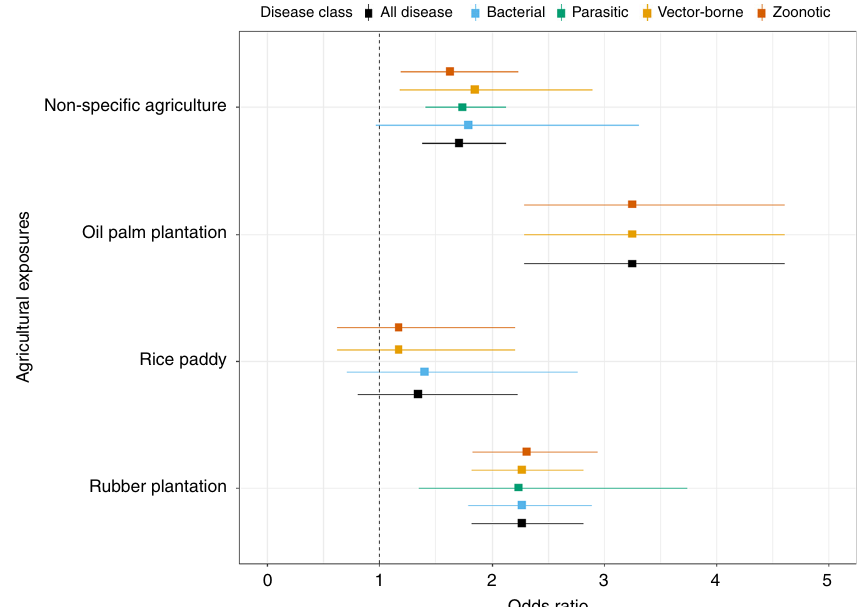
Fig. 5 Agricultural exposure-based subgroup analysis. Subgroups were created a priori based on exposures that had two or more mutually exclusive estimates. Agriculture (non-speci fi c) is de fi ned as a category where a person indicates they work in agriculture regardless of the type of agriculture. Square points show the pooled subgroup estimates and error bars are de fi ned as the 95% con fi dence interval